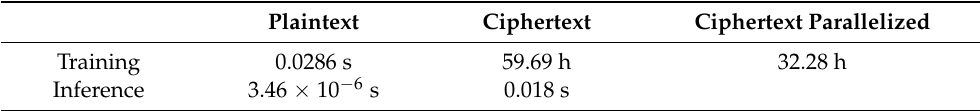
Table 6. Training and inference runtime comparison between plaintext and ciphertext versions in the EEG-based predisposition to alcoholism detection use